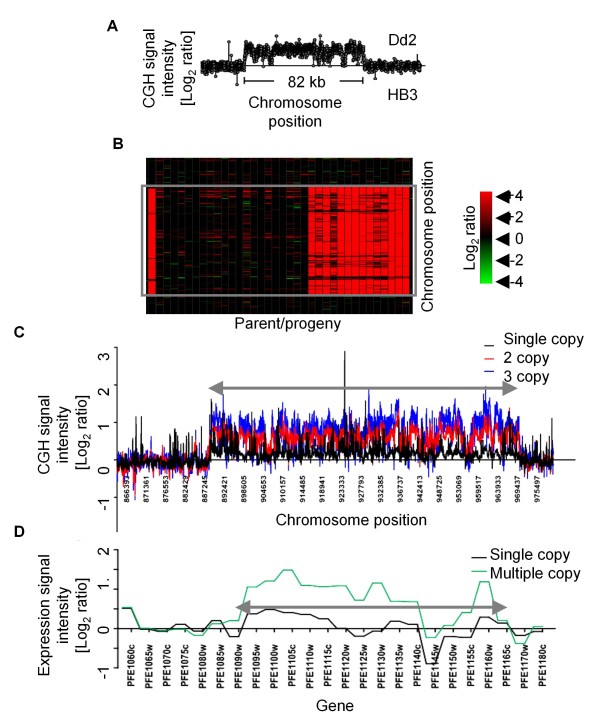
Non-parent copy number forms at a segregating CNV locus. We observed non-parental copy number due to amplification/deamplification at the segregating CNV region in Chr 5, which overlaps the multi-drug resistance gene, pfmdr1. The size and boundaries of the CNV region of the non-parent form remained identical to that of the parent form indicating that all genes within the amplification were amplified or deamplified. (A) Scatter plot of signal intensity ratios for the Dd2 parent (Dd2vs.HB3) hybridization across an 82 kb segregating amplification highlight the presence of the CNV in the Dd2 parent. Fourteen progeny inherit the amplification. (B) Heat map illustrates increased relative probe signal intensities in Dd2 and progeny lines (red) to the reference HB3 parent (amplified region is marked by a grey box). (C) The scatter plot highlights the relative hybridization signal intensities represented as log2 (test/HB3) (amplified region is marked by grey arrow). (C) The progeny exhibit a range of copy number across the amplicon including parent copy number forms as well as non-parent copy numbers reflected by the 3 different groups in the height of the CGH signal intensity across the amplicon. (D) The CNV in the region results in an increase in gene expression (at~18 hrs within the parasite life cycle) in all the multicopy parasites, including the non-parent copy numbers.